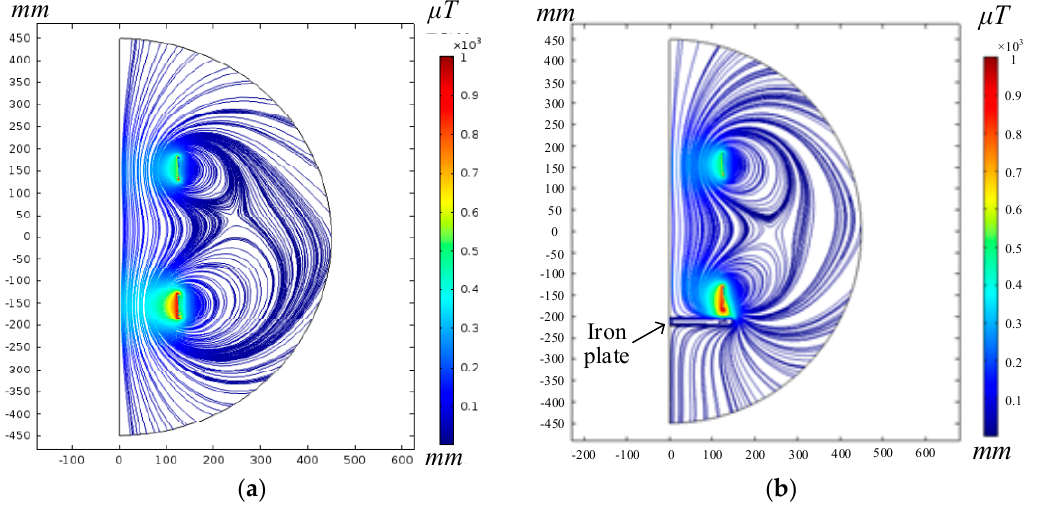
Figure 5. Magnetic field map of helix coil. ( a ) Without metal plate; ( b ) with metal plate. The simulation results of the coil parameters versus the distance between the coil and metal plate are presented in Figures 6 and 7, where the iron plate is placed along the line l 2 and l 3 respectively. It is obvious that the inductance will decrease while the resistance of the coil will increase, i.e., decrease the Q value. As the iron plate approaches the helix coil, especially when the distance is less than 5 cm, the influence of the iron plate is tremendous. As the distance increases, the parameters of the coil get closer to their corresponding rated values.